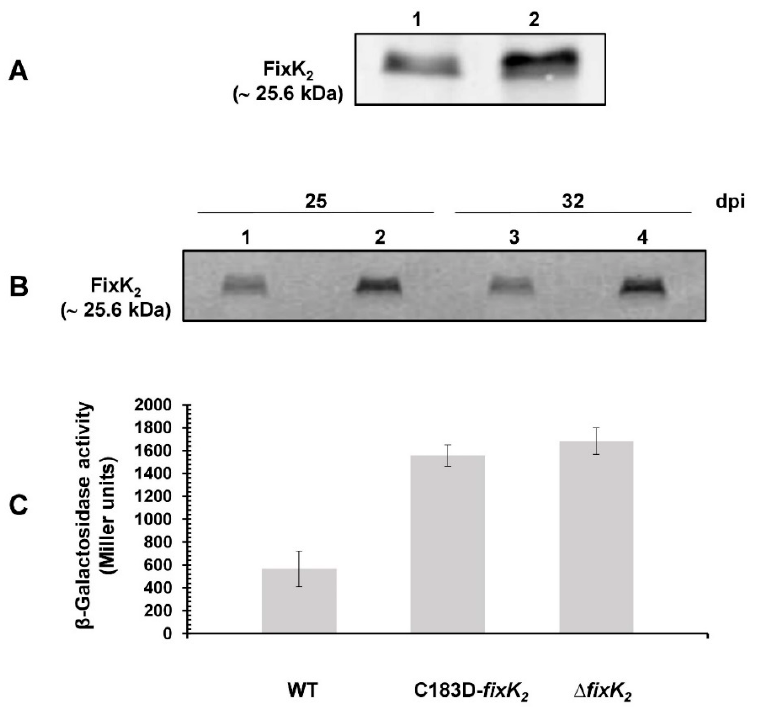
Figure 6. Expression of fixK 2 at protein ( A and B ) and transcriptional ( C ) levels. Steady-state levels of FixK 2 protein in cells cultivated under microoxic free-living conditions ( A ) and in soybean bacteroids collected at 25 and 32 dpi ( B ). Immunodetection was performed with a polyclonal FixK 2 antibody [28]. ( A ) 60 µg of crude extract of wild-type (lane 1) and C183D- fixK 2 strains (lane 2) both cultivated microoxically (0.5% O 2 ). ( B ) 10 µL of soybean bacteroid crude extract of wild-type (lanes 1 and 3) and C183D- fixK 2 strains (lanes 2 and 4). Apparent molecular mass of FixK 2 is shown on the left. Representative results of at least three independent biological replicates are shown. ( C ) β -Galactosidase activity from a chromosomally integrated fixK 2 ′ -’lacZ fusion in B. diazoefficiens wild-type, C183D- fixK 2 and Δ fixK 2 strains. Cells were cultivated for 48 h microoxically (0.5% O 2 ). Values are the means ± standard errors of a typical experiment performed with two parallel cultures assayed in quadruples. The experiment was repeated at least twice. WT, wild type.